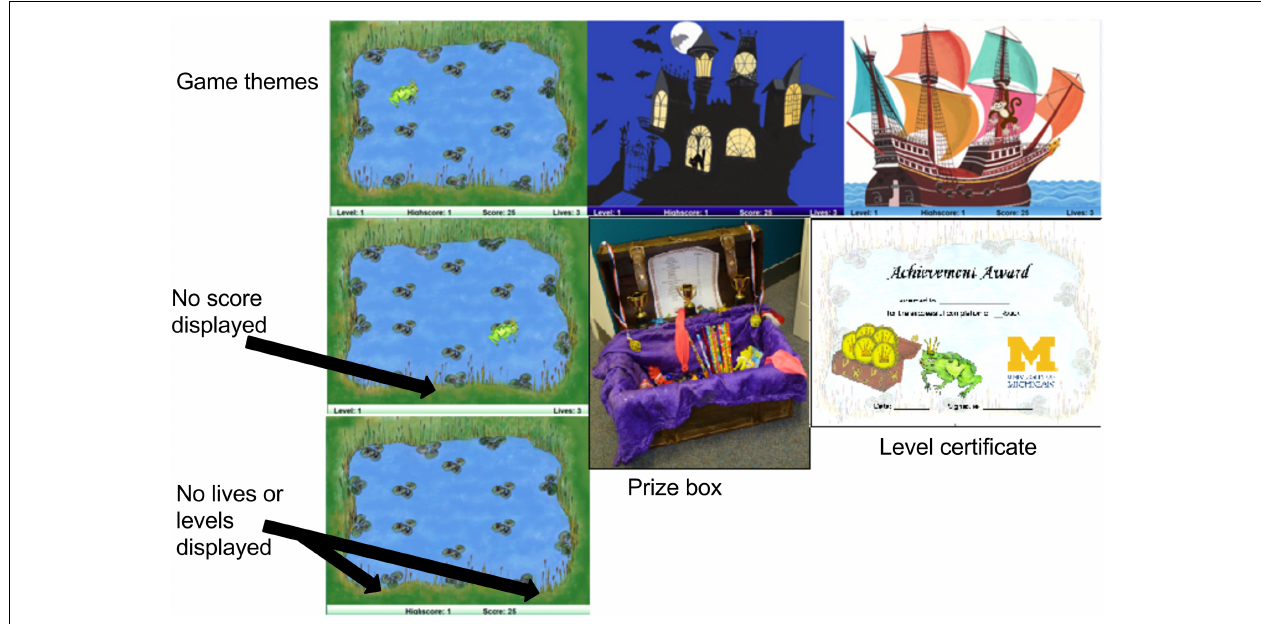
FIGURE 2 | Game elements. Shown here are the three versions of the game theme, the appearance of the game in the original theme if points or lives and levels were removed, the prize box and a sampling of prizes given, and the level certificate template used in the study.